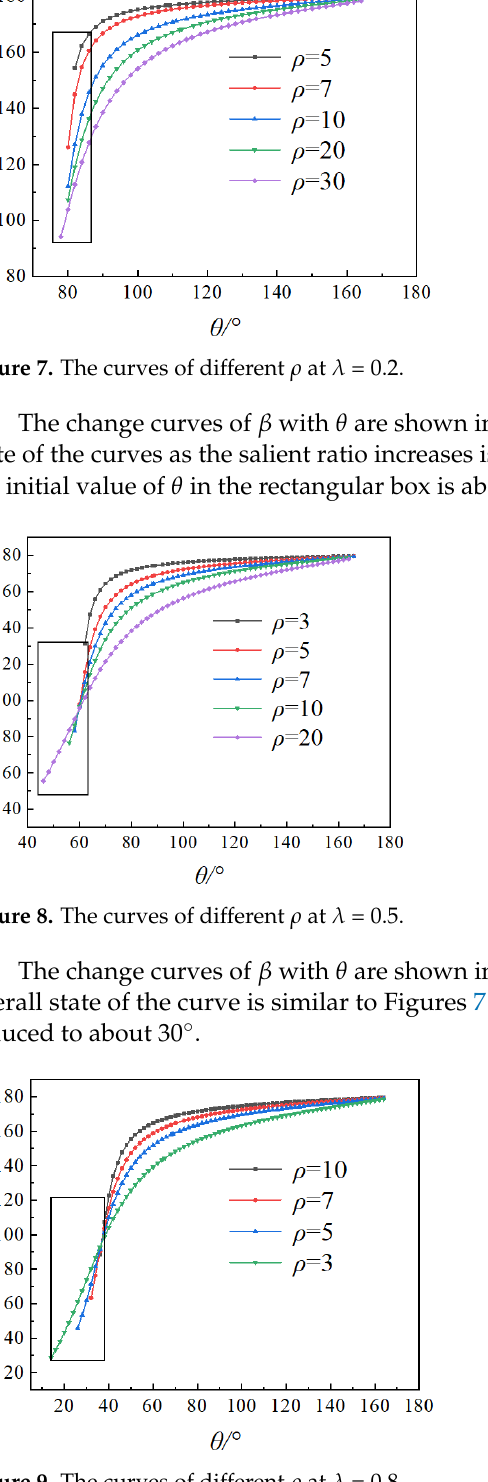
Figure 10. The curves under different parameter matching. By linking the critical point of the power factor curve valley in the λ – ρ coordinate plane, the power factor curve valley area can be obtained. The parameter matching prin- ciples can be obtained as shown in Figure 11. Figure 11. Diagram of power factor curve valley area. The dividing line is not a straight line, and the required ρ increases nonlinearly. The linear relationship is basically between λ = 0.6 and 0.9, and the required ρ value increases sharply in the interval less than 0.5. When the value is low, it is difficult to reach the state of power factor curve valley.